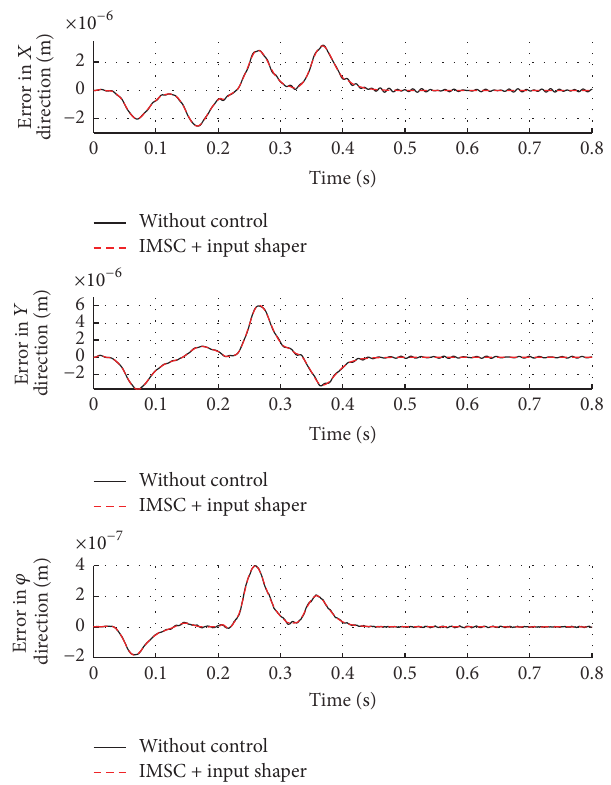
Figure 5: The positioning error of the rigid motion in 3 planar DOFs.